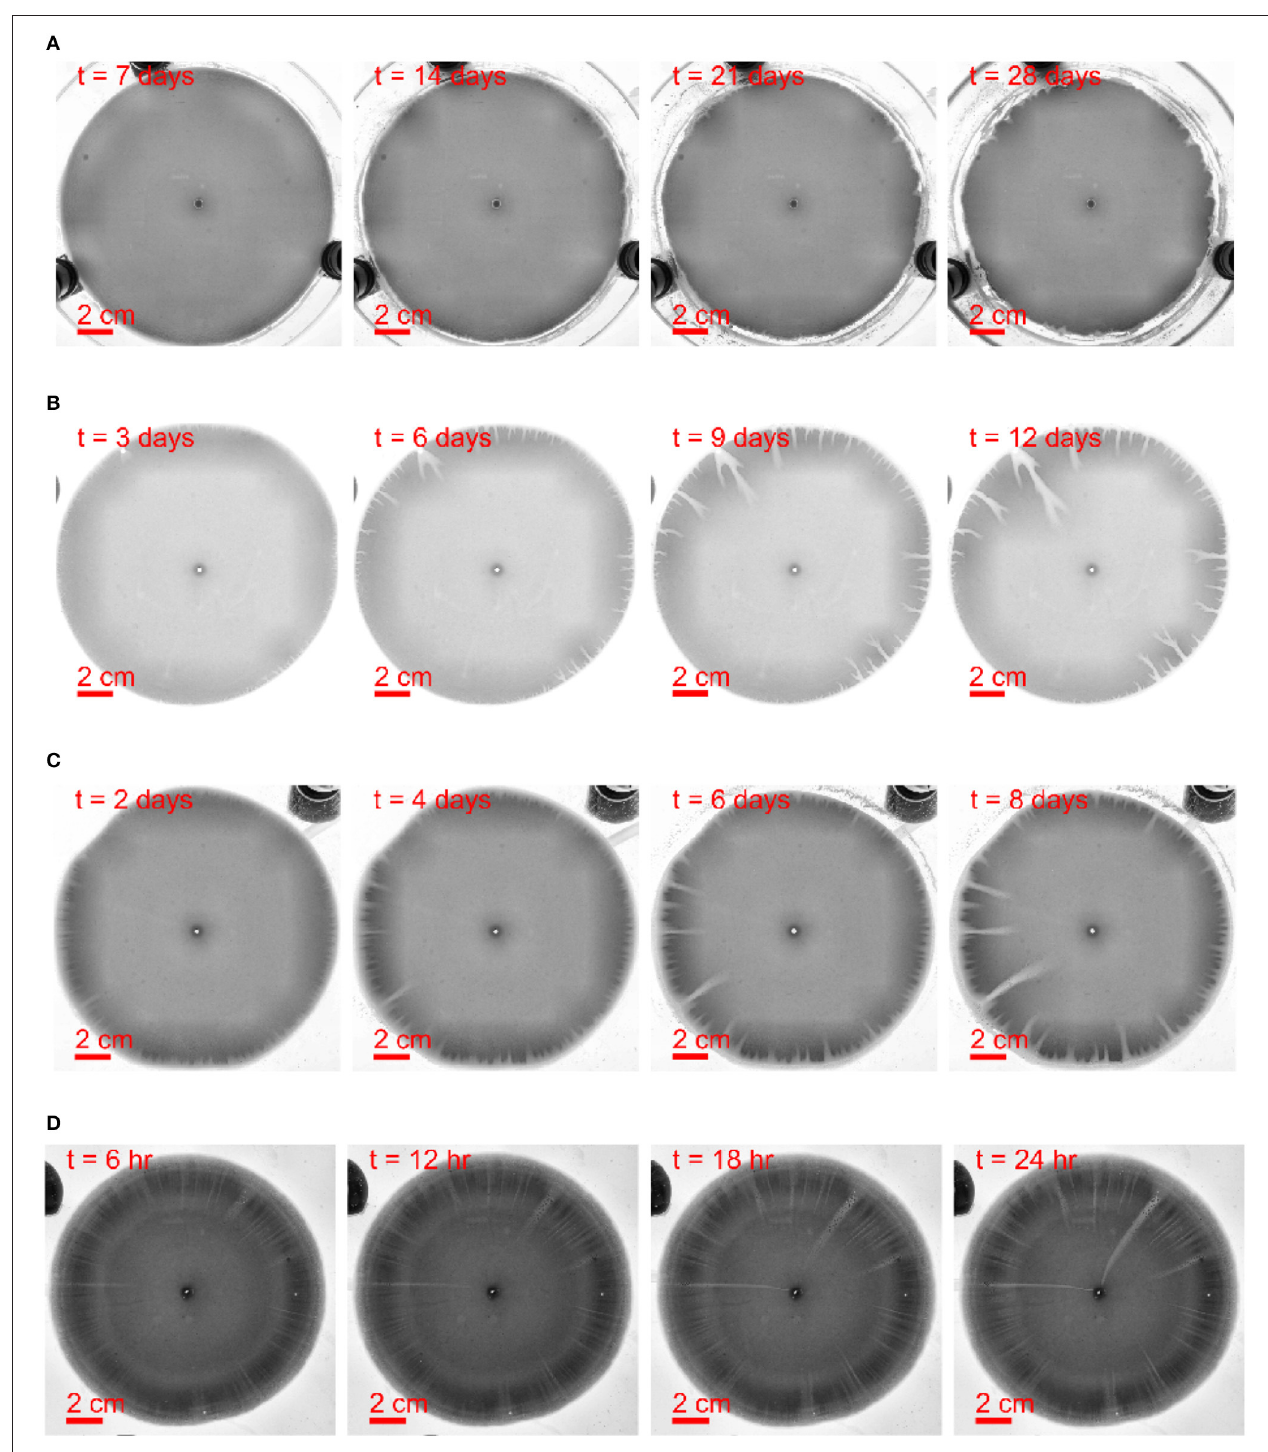
FIGURE 3 | Dissolution pattern evolution with time t, the aperture thickness is 150 µ m and the flow rate increases from top to bottom. The time and length scale are indicated in the images. (A) The withdrawing rate is 1.2 ml / h , the experiment W2 in Table 1 . (B) The withdrawing rate is 7.2 ml / h , the experiment W3 in Table 1 . (C) The withdrawing rate is 10.8 ml / h , the experiment W4 in Table 1 . (D) The withdrawing rate is 60 ml / h , the experiment W5 in Table 1 . The images are adjusted by contrast enhancement.